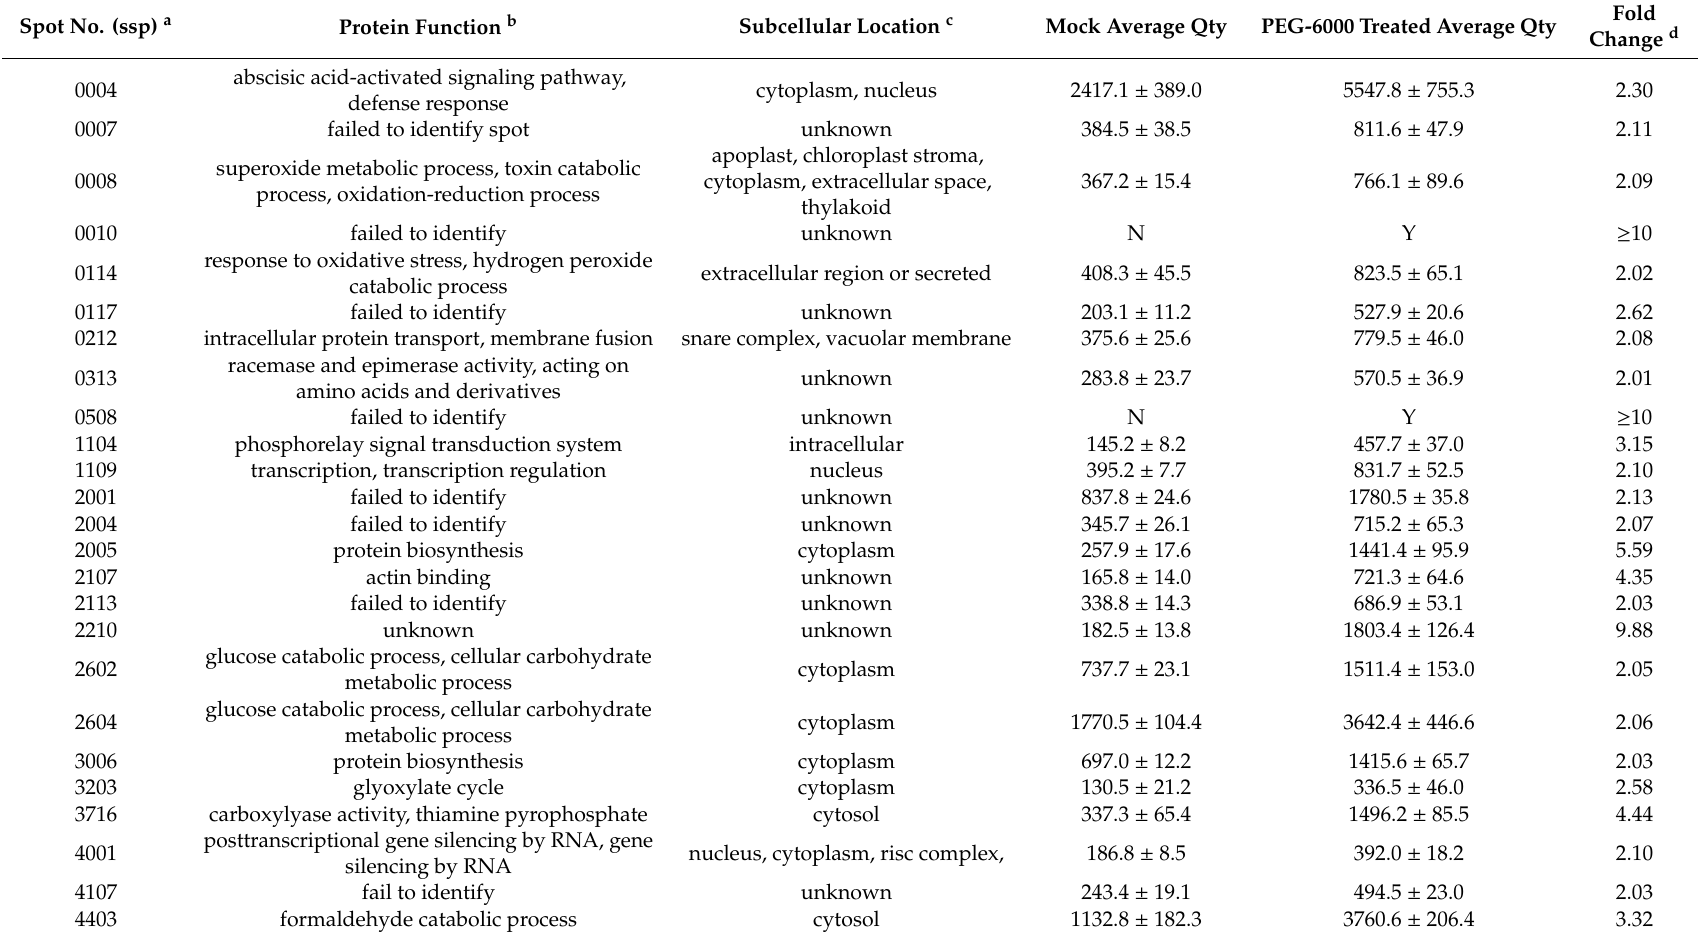
Table 2. Upregulated protein spots in root of sorghum seedlings treated with PEG-6000 imitation drought stress at 24 h posttreatment (hpt) identified by Peptide Mass Fingerprint (PMF) query: the criteria of selection for identification was 2.0 fold change or greater change compared to the mock and a Mascot quality score of over 80. All values are means from three independent